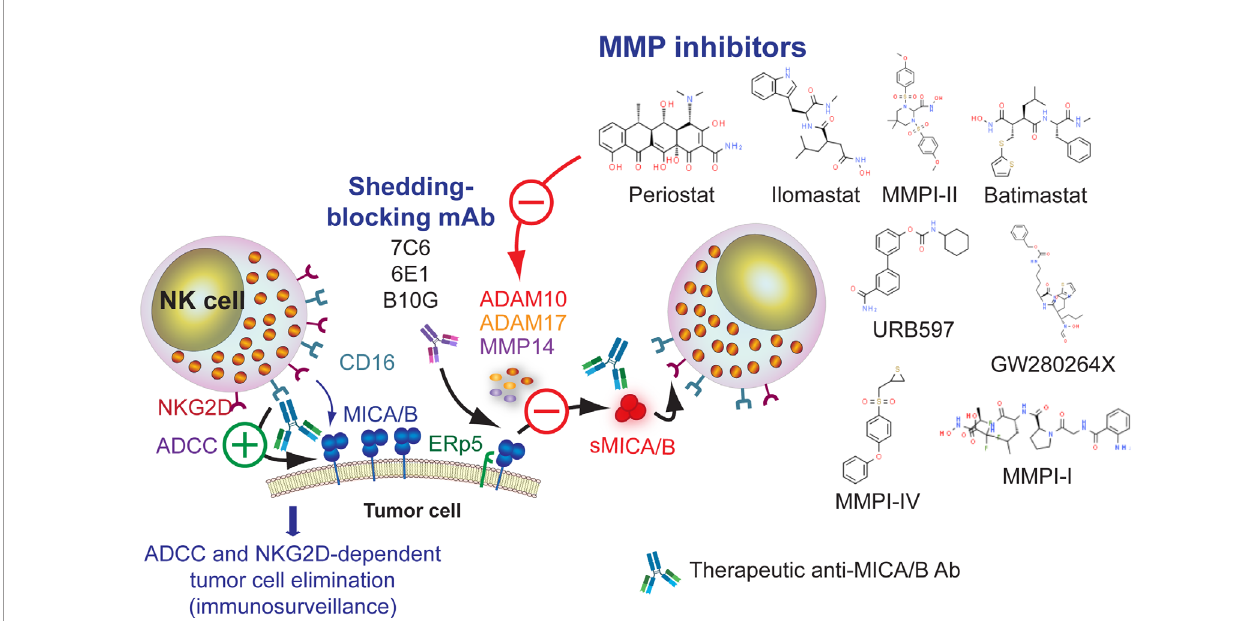
FIGURE 4 | Leveraging anti-MICA/B Ab therapeutic ef fi cacy through combination therapies with pharmacologic inhibition of MMP or with mAb that block MICA/B shedding. Inhibition of MMP with small molecules (detailed in the fi gure) may prevent MICA/B shedding and lead to a subsequent accumulation of MICA/B on the cell surface. A similar effect can be achieved using mAb that interfere with MICA/B shedding. In both cases, inhibition of MICA/B shedding may lead to an improved CD16-dependent ADCC of anti-MICA/B Ab, and a recovery of NKG2D-dependent NK cell-mediated cytotoxicity against tumor